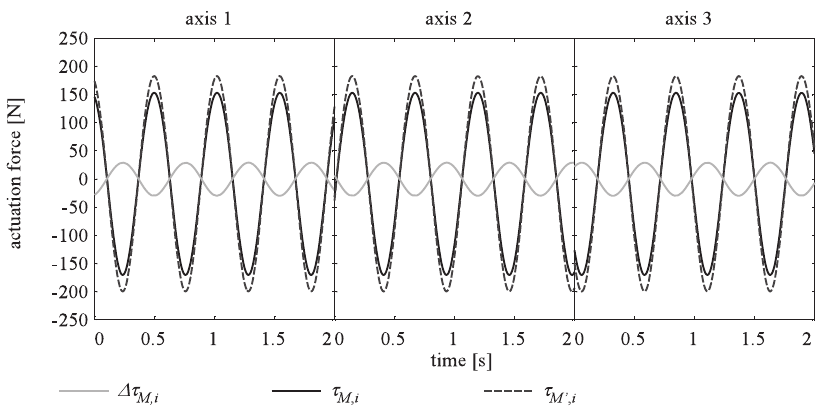
Figure 13. Mass matrix contribution to the dynamics in case of plain and simplified model.